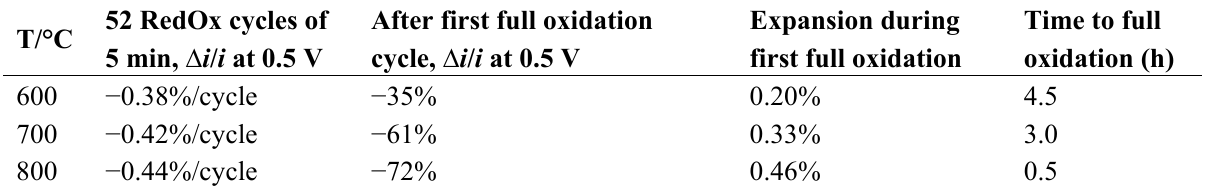
Table 5. Influence of temperature and time of reoxidation on the electrochemical performance and the linear expansion of tubular anode supported cells